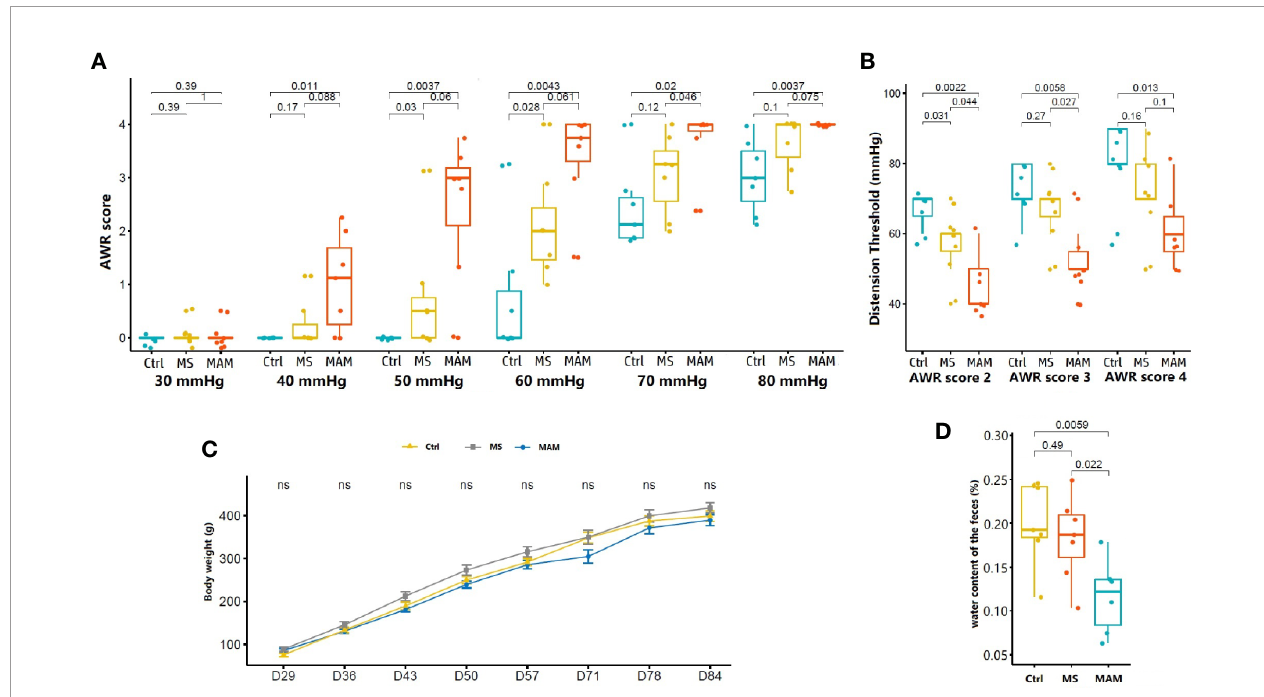
FIGURE 1 | Comparison of visceral hypersensitivity, body weight, and fecal water content in rats of different model groups (n = 7 for each group). (A) Abdominal withdrawal reaction (AWR) scores in response to graded colorectal distension (CRD). (B) Distension threshold values for AWR scores of 2, 3, and 4. (C) Body weight variation of rats (ns, not signi fi cant). (D) Fecal water content for rats in the control, MS, and MAM